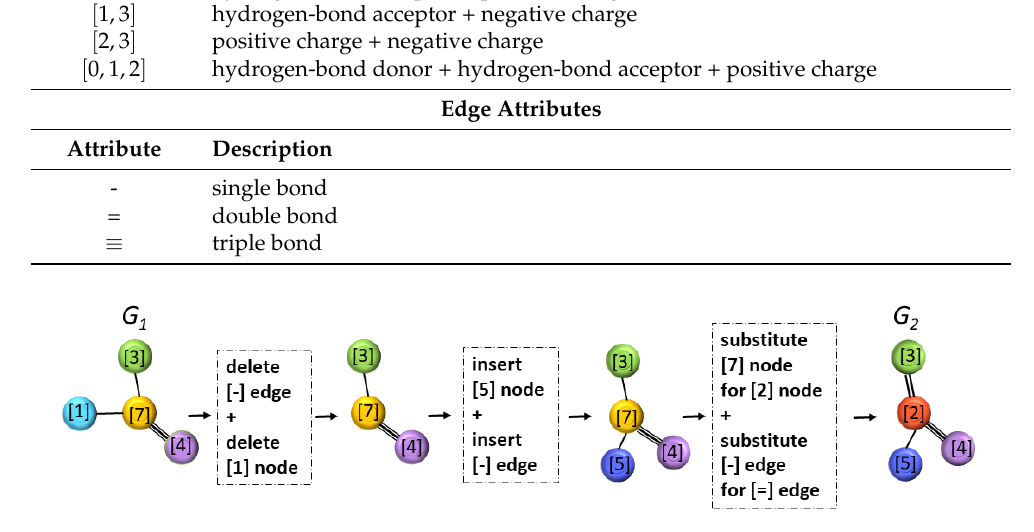
Figure 2. Transformation sequence from graph G 1 to graph G 2